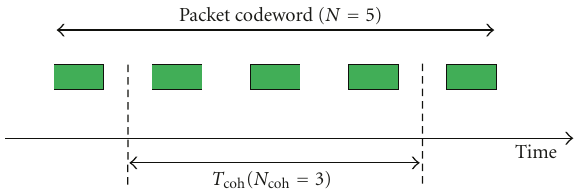
Figure 6: Situation where a packet codeword is distributed over 3 packet groups ( N = 5, N coh = 3, N group =